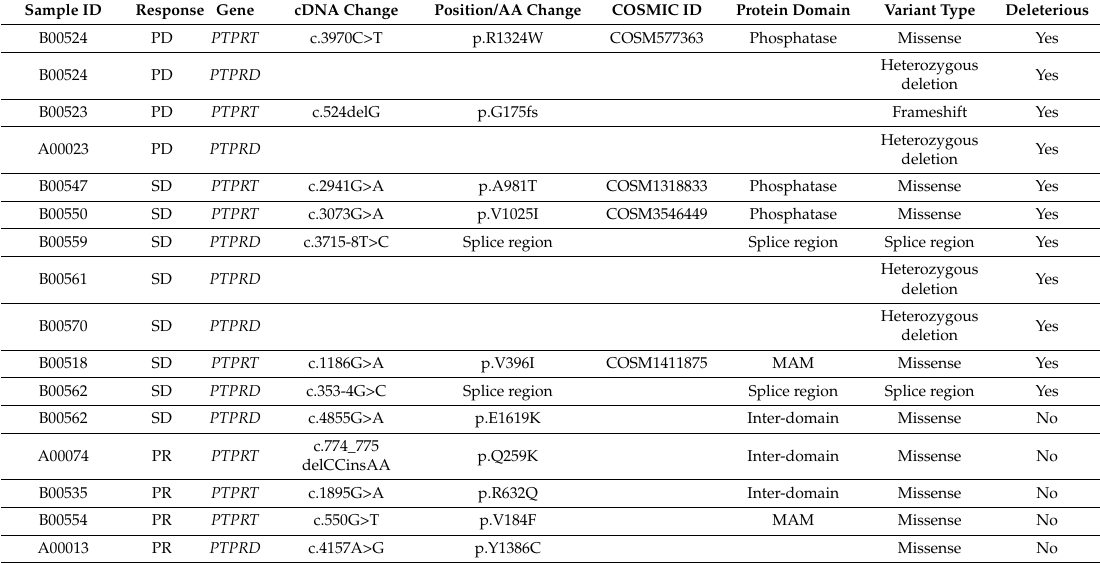
Table 2. List of all PTPRT and PTPRD sequence variants and copy number losses detected in our study